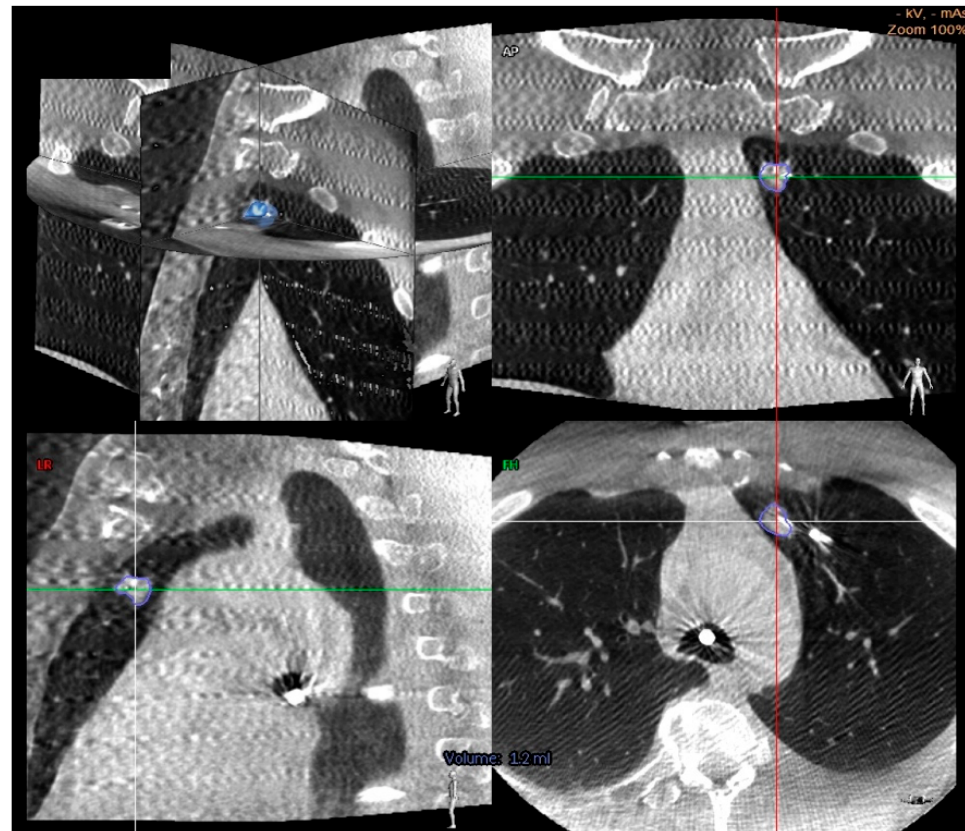
Figure 2. Cone beam CT images demonstrating a center strike represented by a needle within the nodule in axial, coronal, and sagittal planes [56].